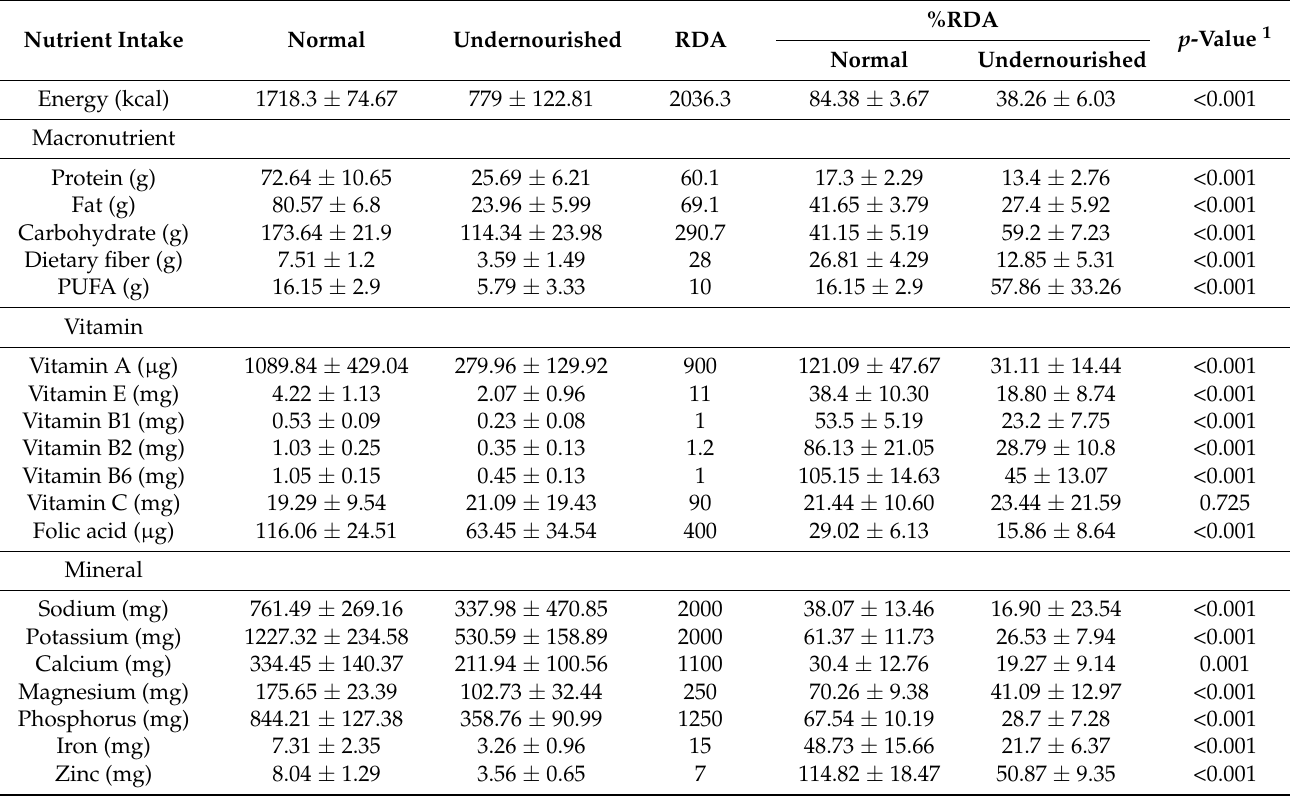
Table 2. Dietary intake of normal vs. undernourished